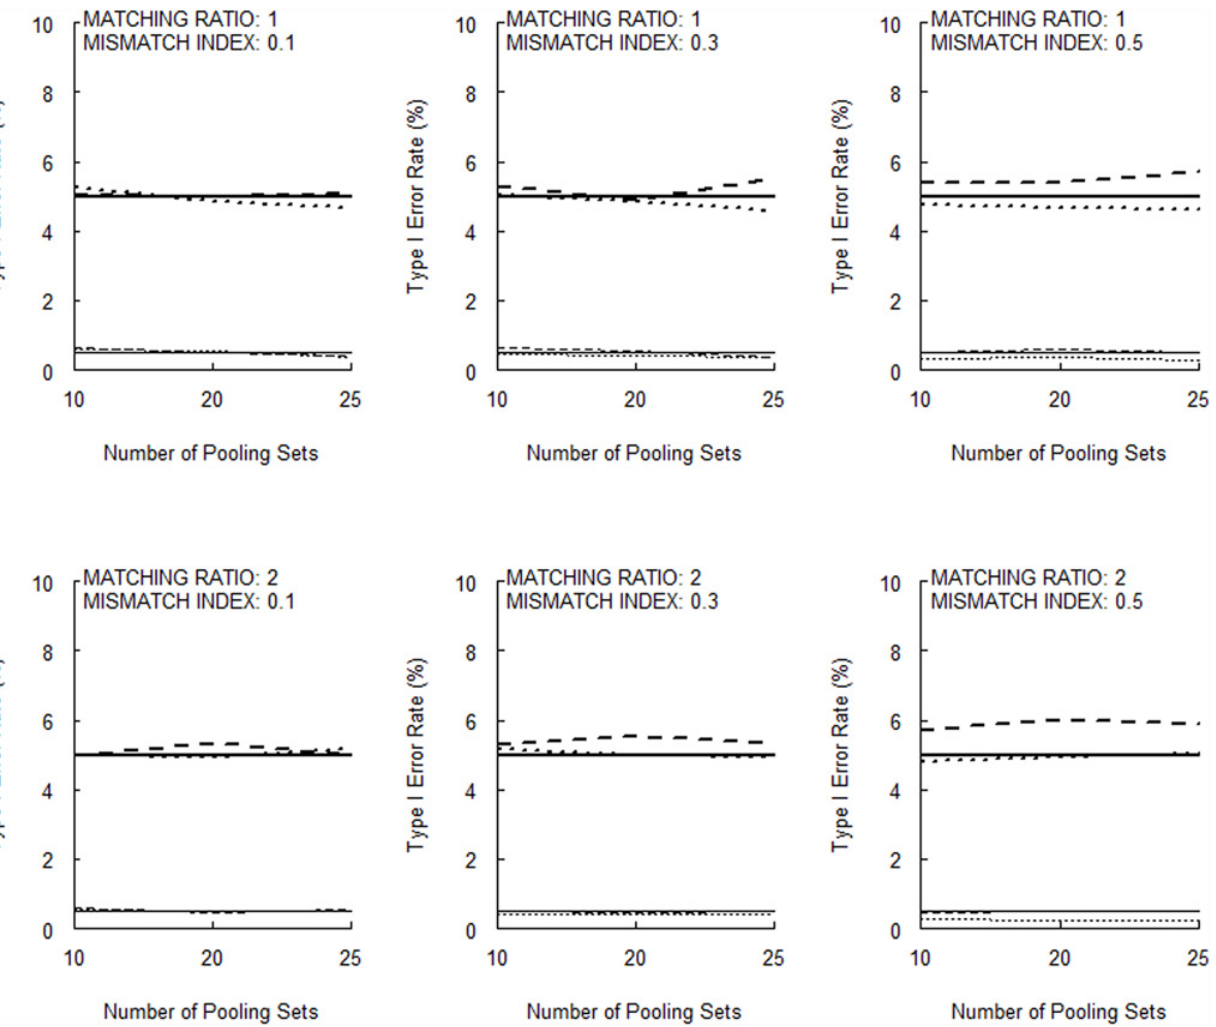
Fig 2. Type I error rates of the permutation test with a total of 50 null markers (bold broken lines, σ = 0.05, α = 0.05; thin broken lines, σ = 0.05, α = 0.005; bold dotted lines, σ = 0.01, α = 0.05; thin dotted lines, σ = 0.01, α = 0.005). The horizontal bold and thin solid lines indicate the nominal α level for α = 0.05 and α = 0.005,